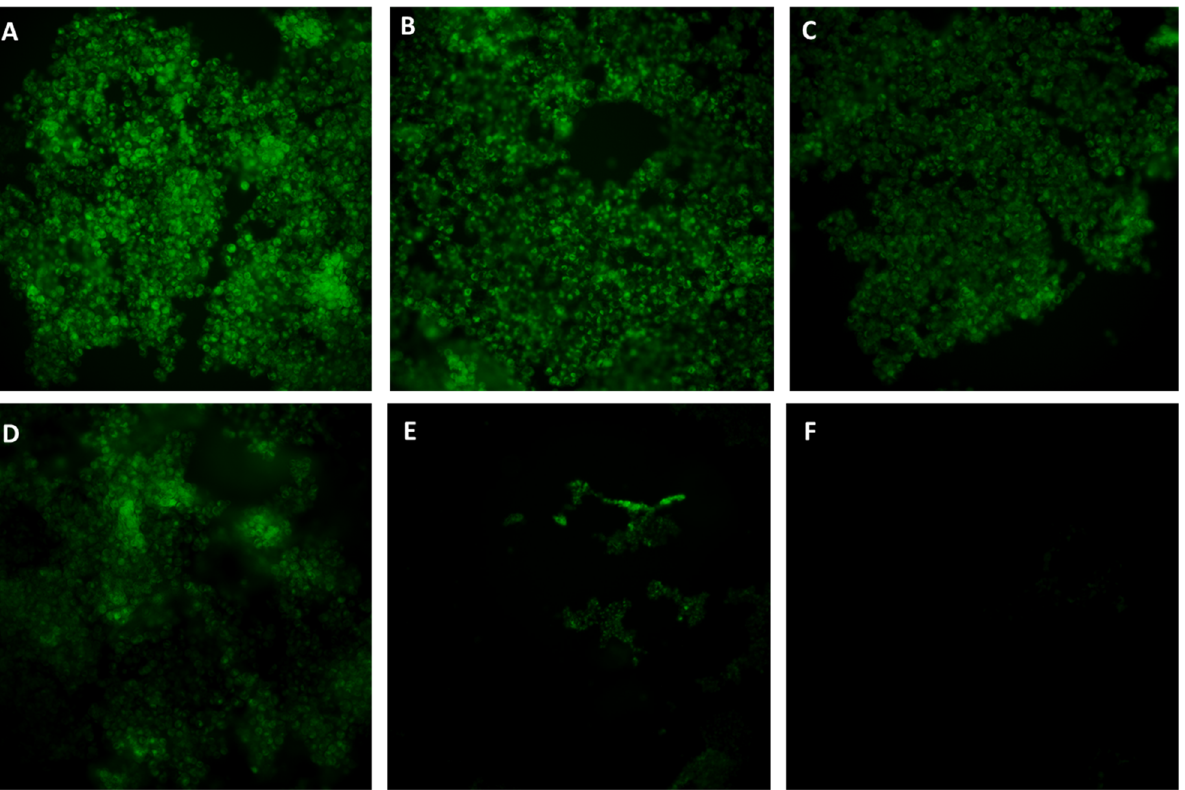
Figure 4. Treatment of U-2 OS cells with MOTS-c decreased the total number of mitochondria as measured by fluorescent microscopy using MitoTracker Green. Representative fluorescent microscopic images of U-2 OS cells treated with ( A ) vehicle (Nuclease-Free Water) and ( B – D ) MOTS-c after staining with MitoTracker Green FM (200 nM) ( E ) negative control: chloramphenicol (1 μM) and ( F ) assay control or probe control (no MitoTracker Green FM). There was depletion in MitoTracker Green intensity following increase in MOTS-c concentration ( B ) 25 μM ( C ) 50 μM and ( D ) 100 μM. U-2 OS cells grown in Dulbecco’s modified Eagle’s medium (DMEM) supplemented with 10% fetal bovine serum (FBS) plus 1% pen-strep were treated with vehicle (Nuclease-Free Water) or MOTS-c (25, 50 or 100 μM) for 48 h and fluorescent microscopy was performed to quantify the number of mitochondria using MitoTracker Green, which localizes to mitochondria regardless of mitochondrial membrane